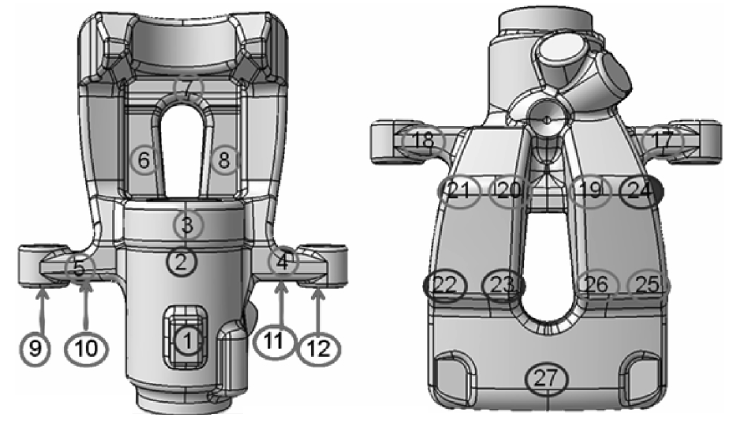
Fig. 5. Visualization of the measured points on the